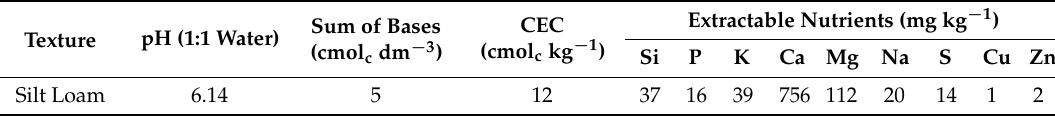
Table 5. Soil characterization analysis before experiment